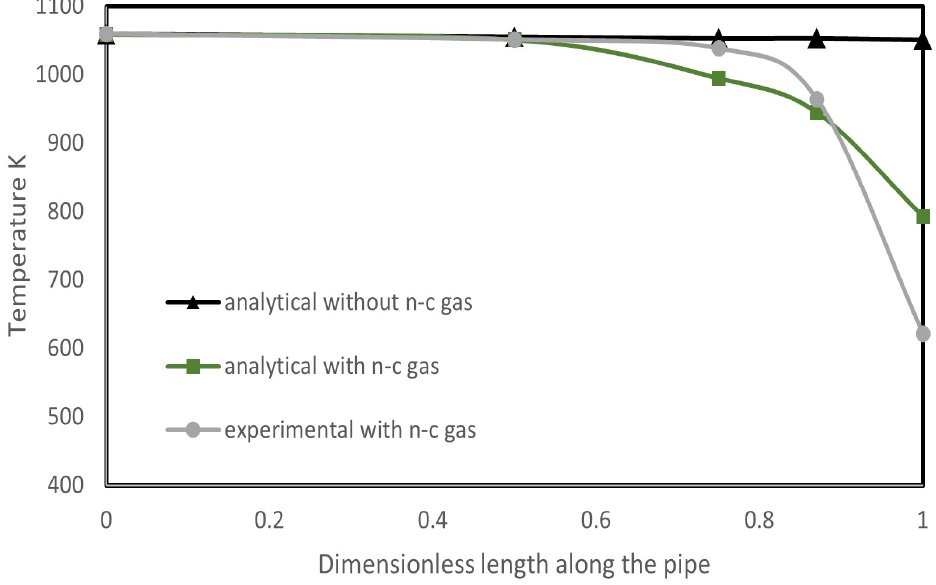
Figure 7. Temperature profile along the RRHP by experiment and analytical solutions (data from [47]).